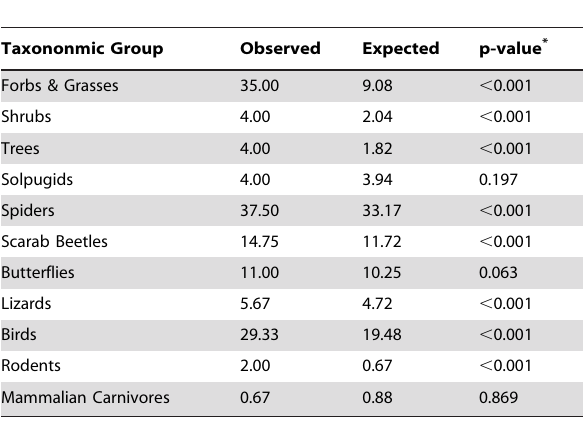
Table 3. Observed and expected beta diversity values based on the additive partitioning method of Veech et al.